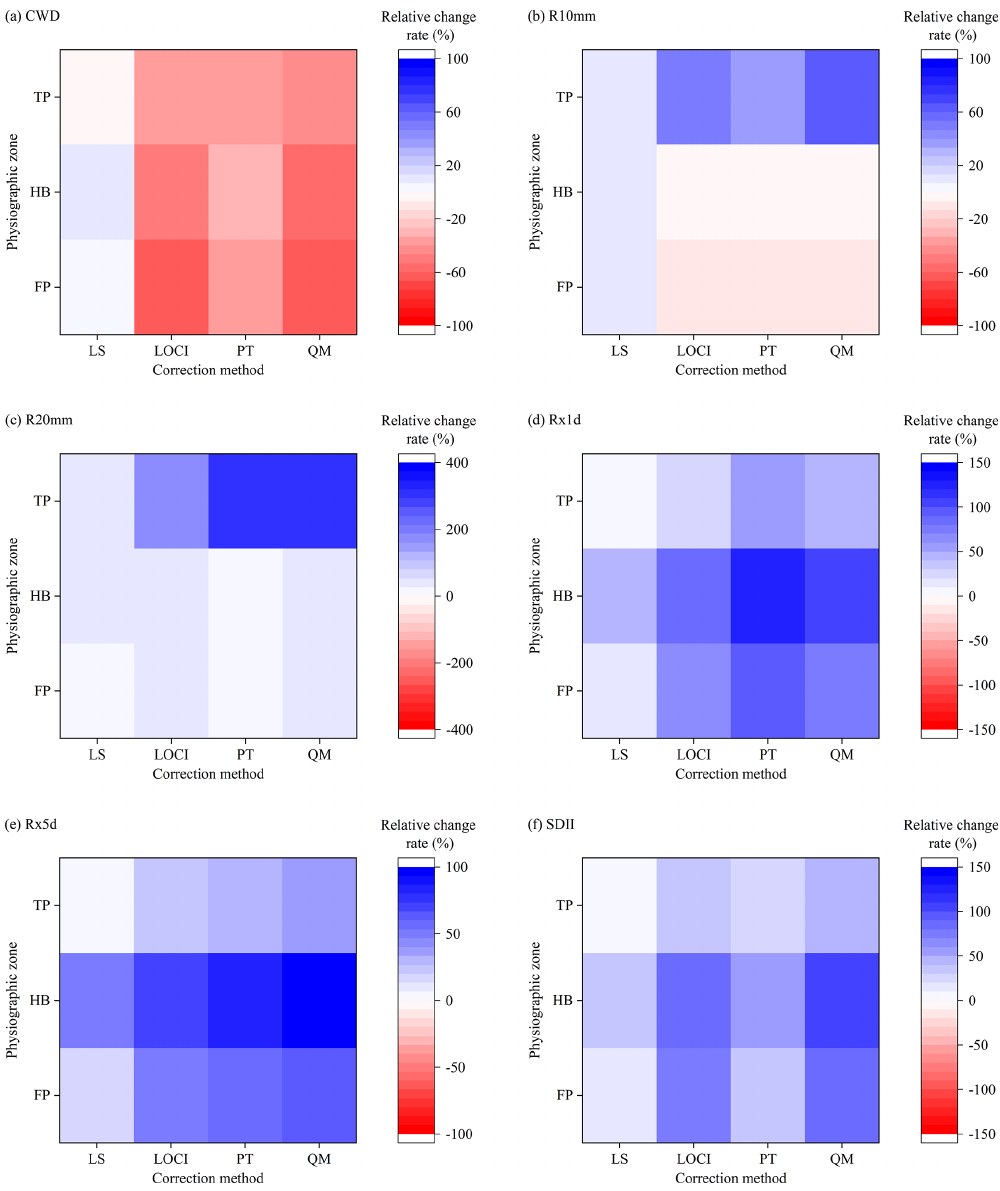
Figure 5. Relative change rate of (a) CWD, (b) R10mm, (c) R20mm, (d) Rx1d, (e) Rx5d, and (f) SDII during JJAS for the original and corrected APHRODITE